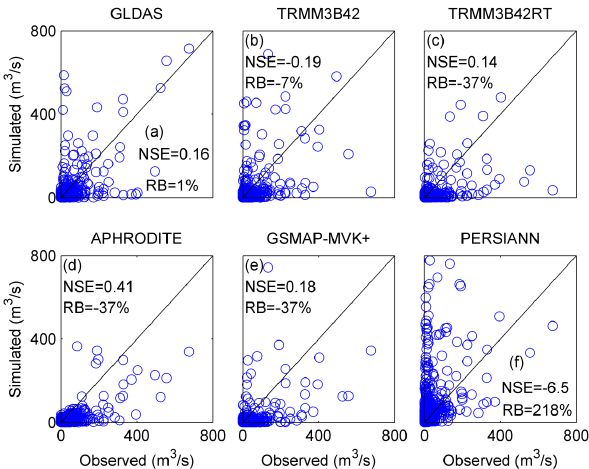
Figure 11. Scatter plots of simulated discharges with TOPMODEL against gauge observations at a daily